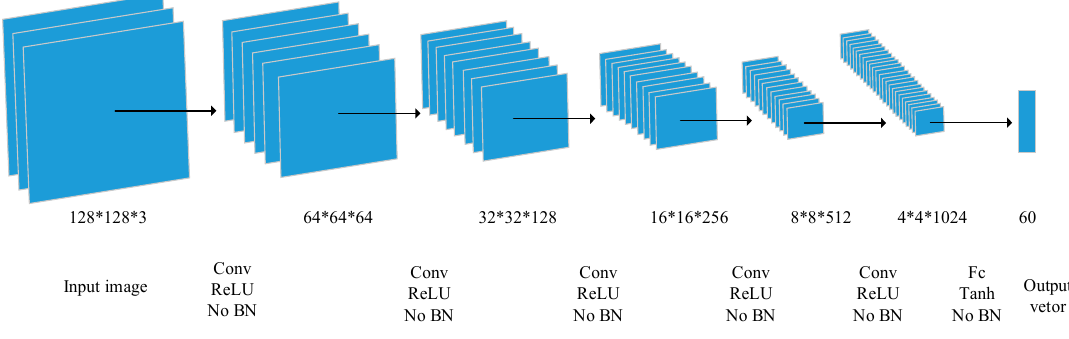
Figure 3. Convolutional network structure of the encoder.